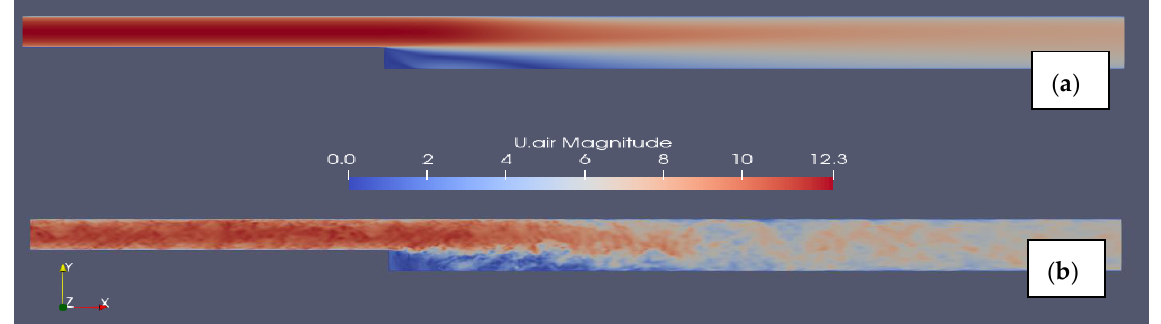
Figure 5. OpenFOAM simulated velocity fields (magnitude) under ( a ) RANS (kOmegaSST) and ( b ) LES (dynamicKEqn) frameworks.